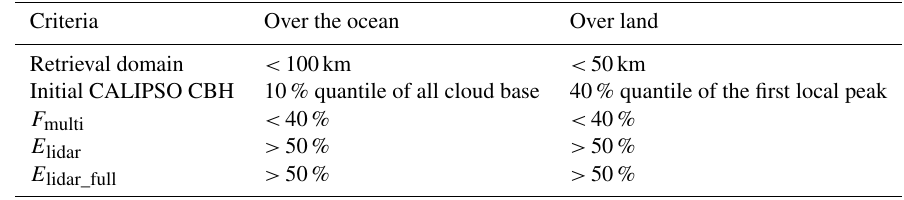
Table B2. Final retrieval criteria used over the ocean and